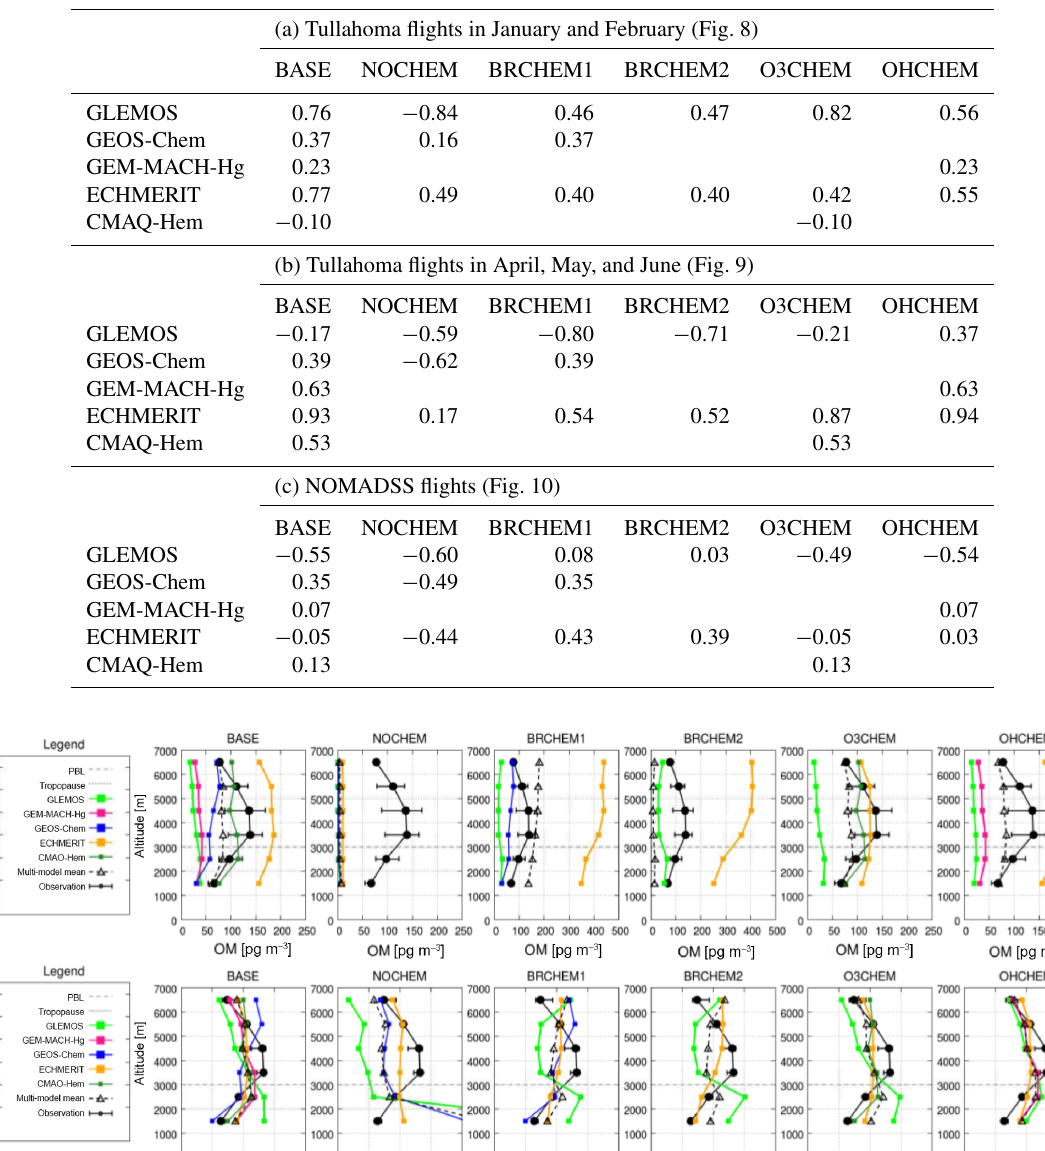
Table 5. Correlation of individual models for OM profiles depicted in Figs. 8, 9, and 10.